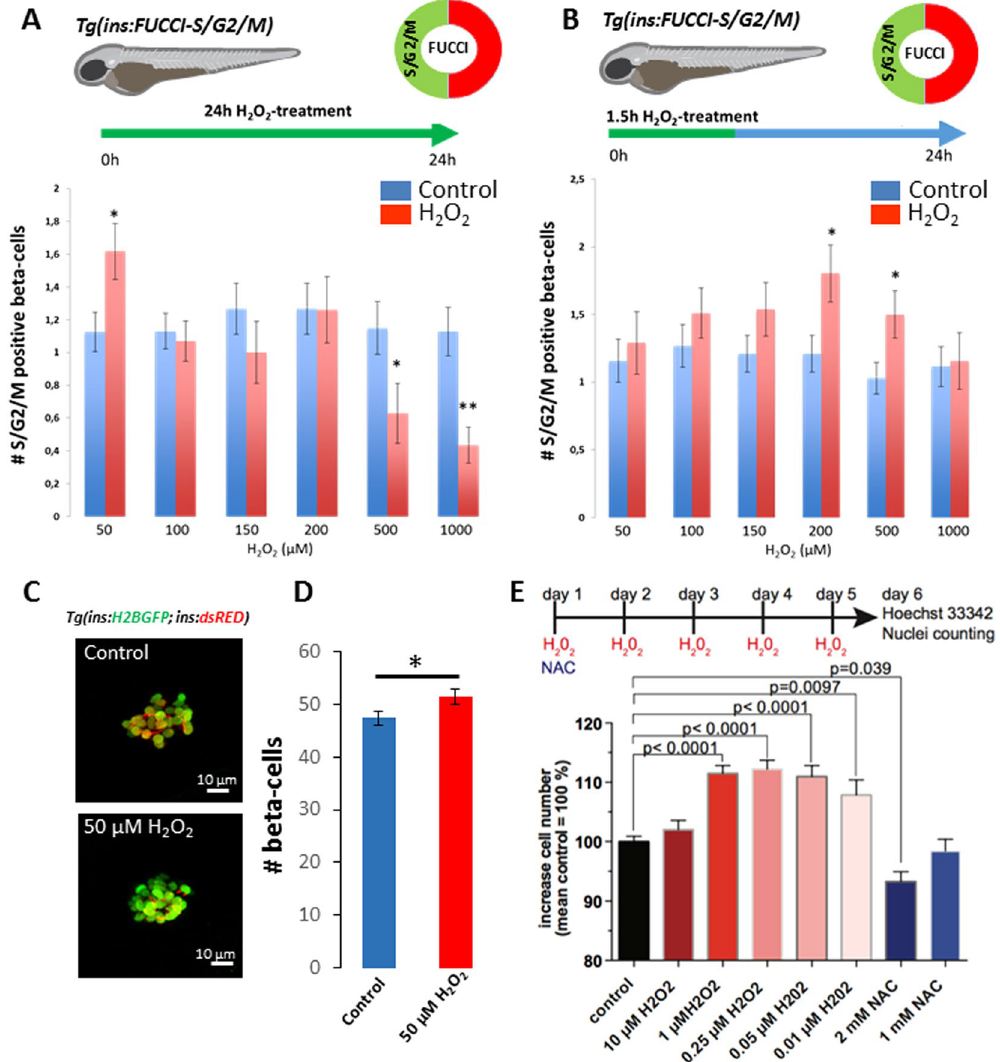
Figure 4. Different levels of H 2 O 2 induce beta-cell proliferation and quiescence. ( A ) Quantification of the number of Tg ( ins :FUCCI-S/G2/M) + beta-cells after continuous treatment with increasing concentrations of H 2 O 2 from 3 to 4 dpf. The treatment with 50 μ M H 2 O 2 (n = 89 larvae) increased the number of Tg ( ins :FUCCI-S/G2/M) + beta-cells compared to controls (n = 104 larvae) (p = 0.025) whereas the treatments with 500 and 1000 μ M H 2 O 2 decreased the number of Tg ( ins :FUCCI-S/G2/M) + beta-cells (n = 38 larvae for 500 H 2 O 2 μ M; n = 63 larvae for controls; p = 0.03) (n = 46 larvae for 1000 μ M H 2 O 2 ; n = 78 larvae for controls; p = 0.0004). ( B ) Quantification of the number of Tg ( ins :FUCCI-S/G2/M) + beta-cells in 3 dpf larvae treated with increasing concentrations of H 2 O 2 for 1.5 hours followed by a wash-out. The number of Tg ( ins :FUCCI-S/G2/M) + beta-cells was examined 24 hours after the initiation of the treatment. The short treatment with 200 and 500 μ M H 2 O 2 increased the number of Tg ( ins :FUCCI-S/G2/M) + beta-cells compared to controls (n = 51 larvae for 200 μ M H 2 O 2 ; n = 86 larvae for controls; p = 0.02) (n = 68 larvae for 500 μ M H 2 O 2 ; n = 96 for larvae for controls; p = 0.02). ( C ) Confocal projections of the principal islets of 4 dpf Tg ( ins : H2B-GFP; ins : dsRED ) larvae treated from 3 to 4 dpf with 50 μ M H 2 O 2 . ( D ) Quantification of the average number of beta-cells marked with H2B-GFP in controls and H 2 O 2 - treated larvae. H 2 O 2 -treatement increased beta-cell number (n = 30 larvae) compared to controls (n = 26 larvae) (p = 0,046). Error bars = SEM. ( E ) Bar chart showing the increase in the number of INS-1 cells after H 2 O 2 or NAC-treatments. Data from four independent experiments and > 3.5 × 10 5 cells per condition were normalized to the mean of control treated cells ( = 100%) and analyzed for significance using a one-way ANOVA with Dunnett’s multiple comparison test. Error bars indicate S.E.M. Cartoons with permission by Luis